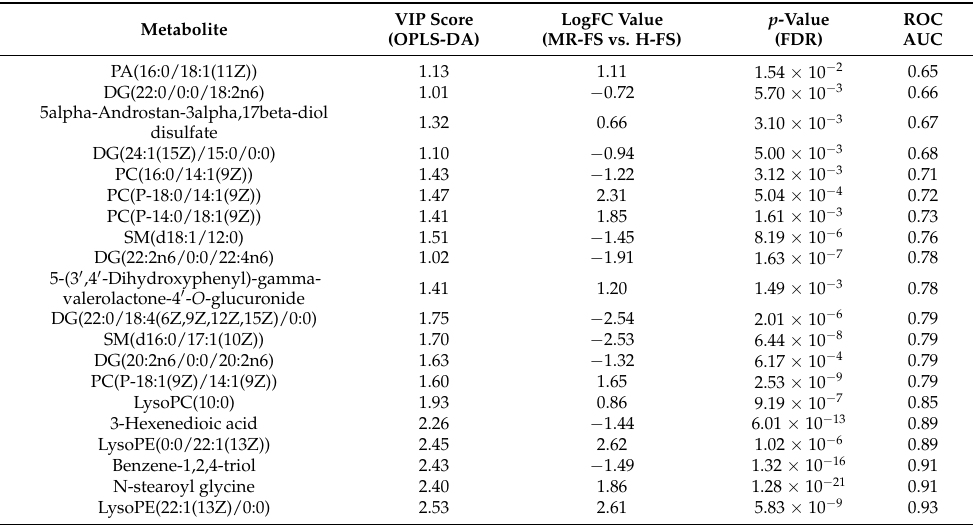
Table 1. Most discriminant marker compounds characterizing the comparison of MR-FS vs. H-FS. Each compound is reported with its VIP score (from the OPLS-DA supervised modelling), LogFC value, p -value, and ROC AUC value. FDR = false discovery